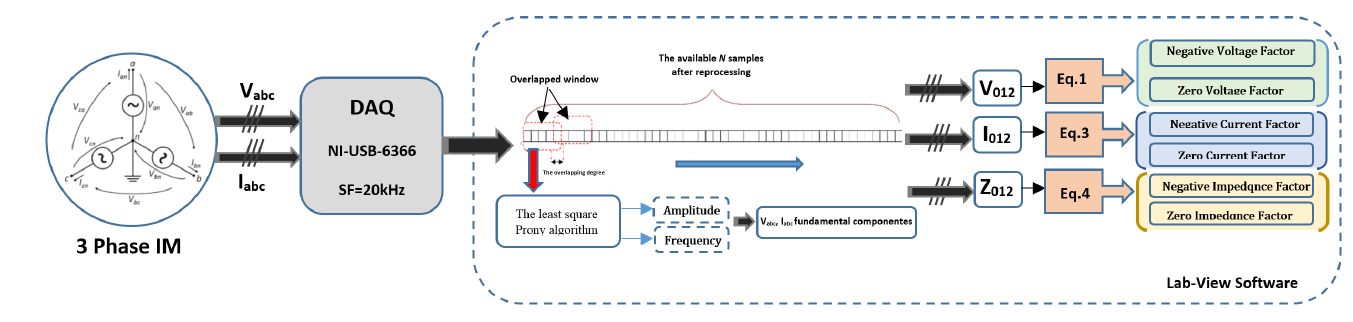
Figure 2. Illustrative scheme of the online implementation of the proposed